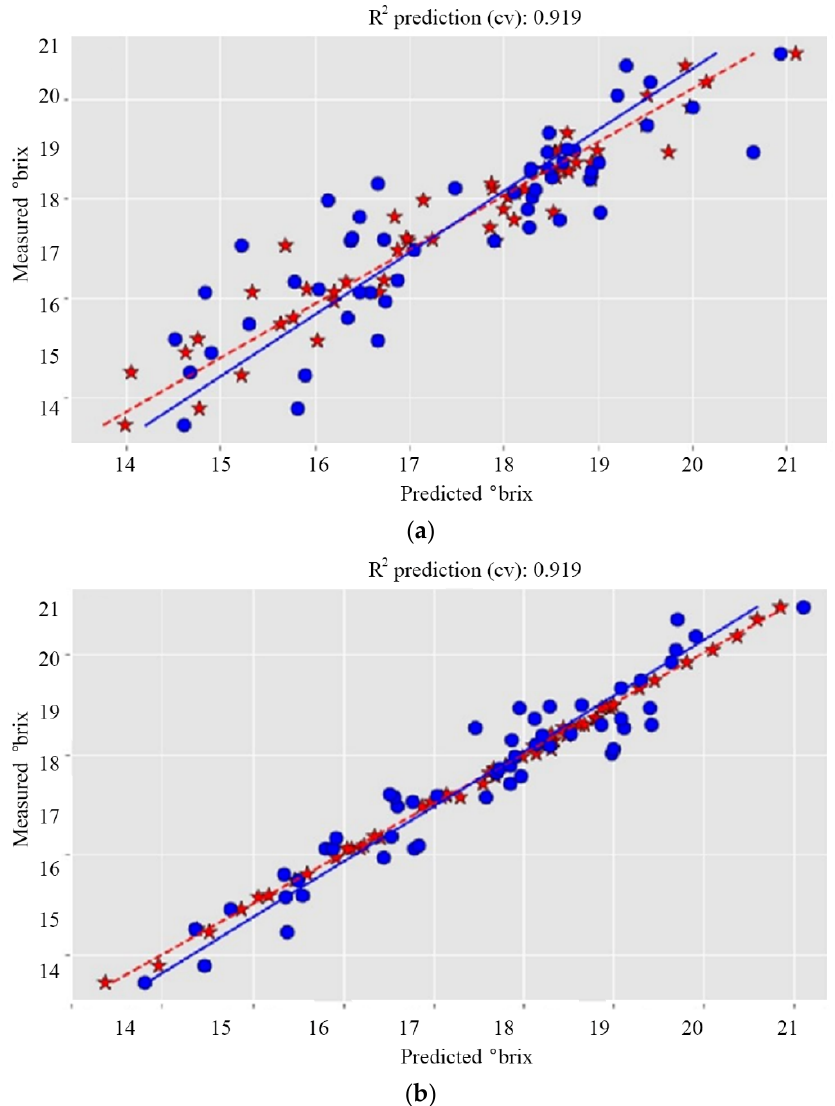
Figure 3. PLS regression results. ( a ) Plots of calculated and predicted TSS, derived from the entire dataset 1 (harvest 1) of reflection FT-NIR spectra, against the chemometrically measured (actual) values. The line fitting the asterisk scatter plot represents a plot of the calculated by the regression model against the actual TSS values. The line fitting the scatter plot of the circles represents a plot of the predicted by the model against the actual values. The R 2 of prediction is 0.750. ( b ) Same plot using the selected wavenumber dataset (absxcoefs) of the same harvest 1. The two lines, that of prediction and that of calculation from the model, almost coincide against the actual sugars.